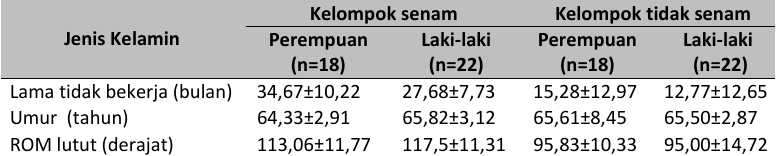
Tabel 1. Karakteristik sampel lanjut usia menurut umur, jenis kelamin, lama tidak